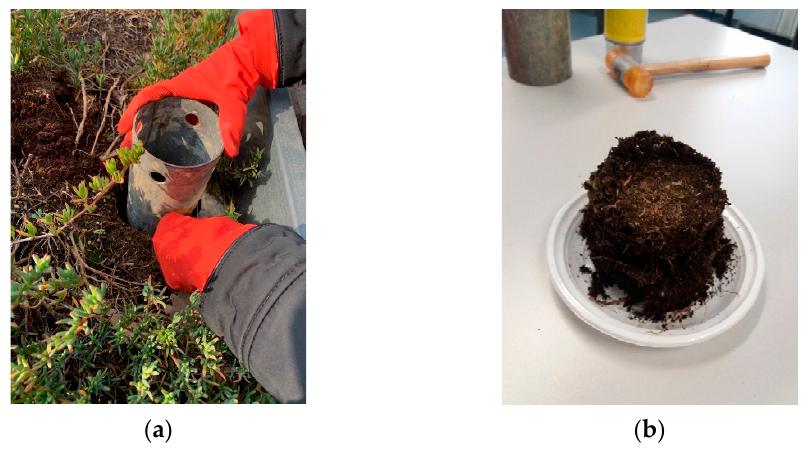
Figure 2. ( a ) GRs soil sampling in 2019; ( b ) Sample with roots.